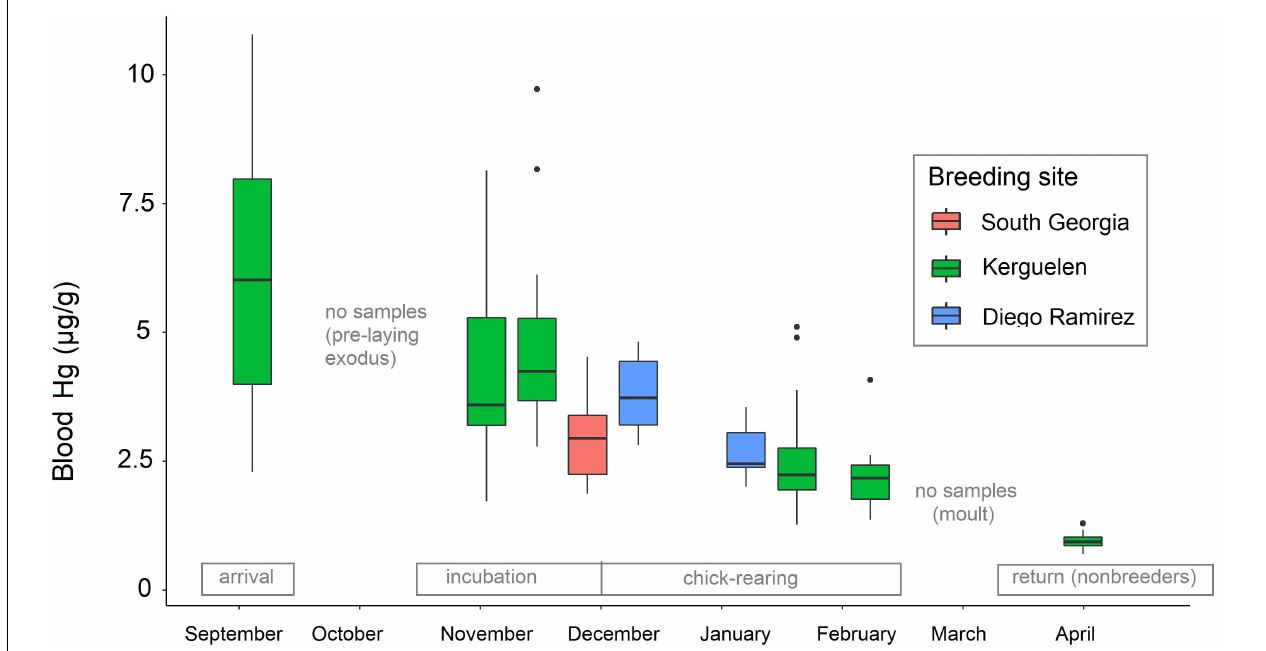
FIGURE 9 | Temporal changes in mercury concentrations in blood of Blue Petrels from different breeding locations over the breeding season.